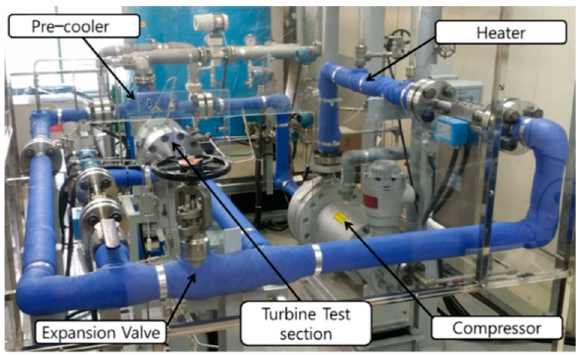
Figure 10. S-CO 2 power cycle experimental facility (S-CO2PE) in KAIST.